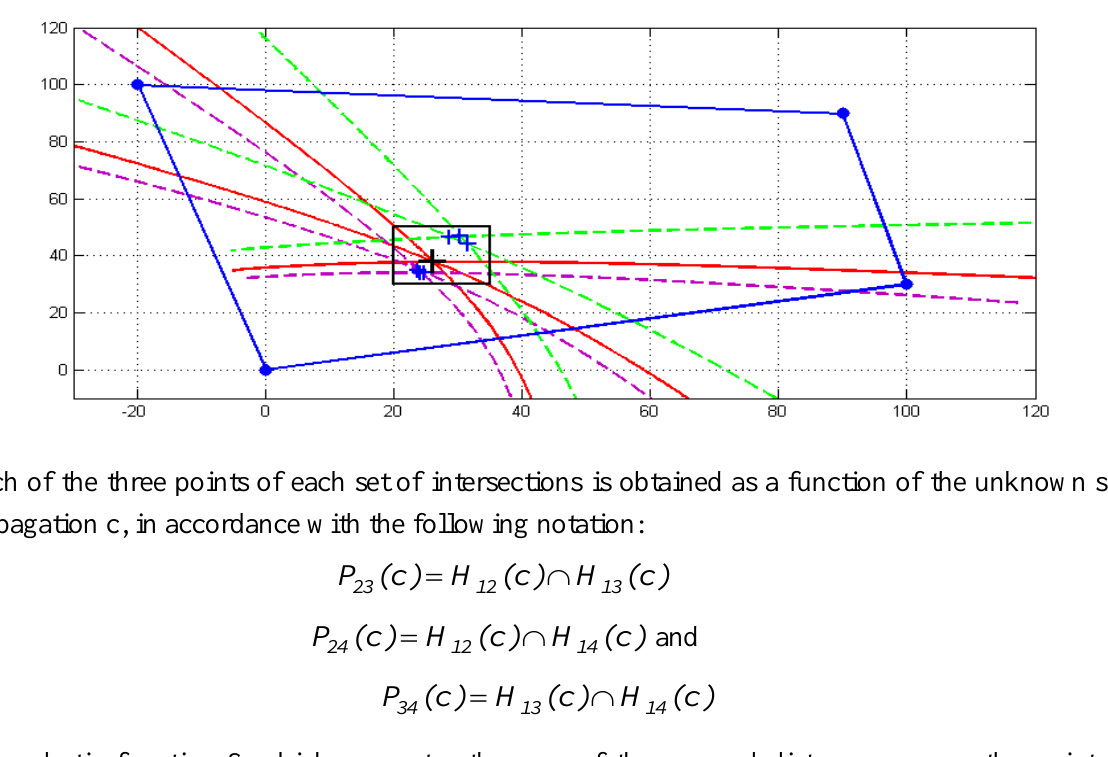
Figure 5. One set (correct) and two sets (not correct) of intersections with different computed speed of propagation